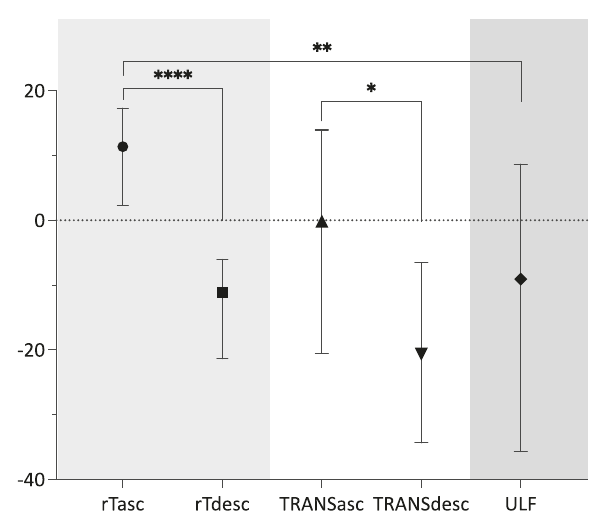
Fig. 1 Motor cortex excitability in regular tapping, transitions, and freezing. Overview of all conducted Mann-Whitney U tests: we compared normalized MEP sizes (ascending slope vs. descending slope) during regular tapping (rTasc vs. rTdesc), the transition (TRANSasc vs. TRANSdesc), and regular tapping ascending (rTasc) with ULF. MEP sizes were greater at ascending (downward press) compared to descending (upward release) during both regular tapping and transition (see Methods for de fi nition of transition ). MEPs evoked at rTasc (successful motor output) were also greater than during ULF (unsuccessful motor output), but overall MEP size variability increased when freezing (ULF). X-axis: % change from block average as median ± 95%-con fi dence interval; Y-axis: motor behavioural